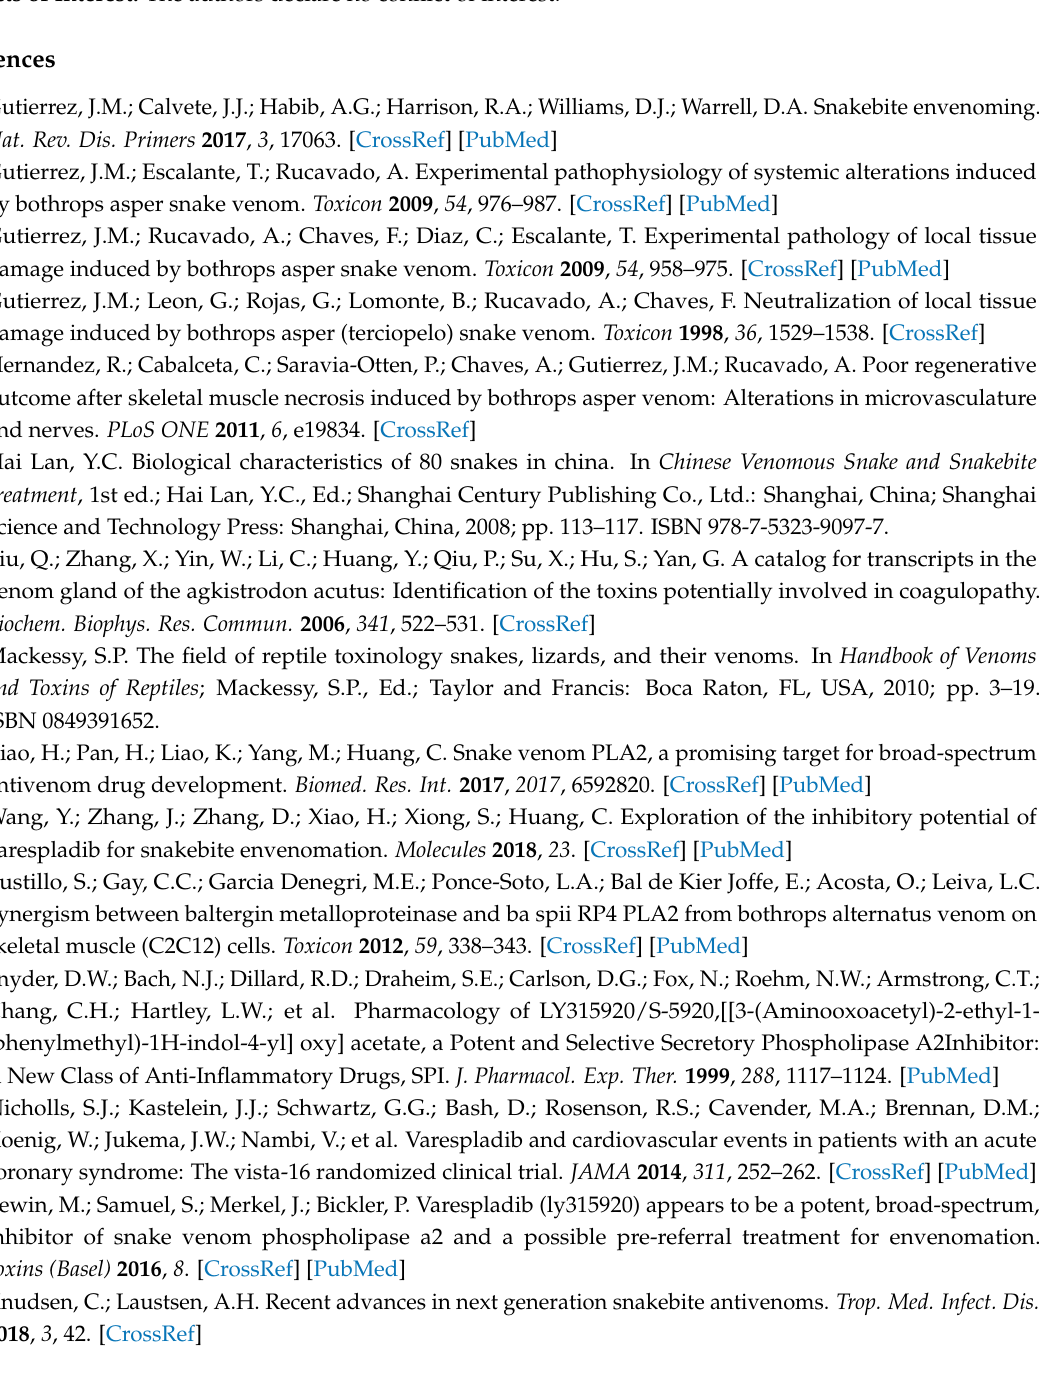
Supplementary Materials: The following supplementary materials are available online. Figure S1. Time course variation of gastrocnemius muscle weight. Figure S2. Anti-hemorrhage effect of varespladib administered after D. acutus envenoming. Figure S3. Variation of gastrocnemius muscle edema. Figure S4. Variation of serum CK and LDH1 at day 1, 3,